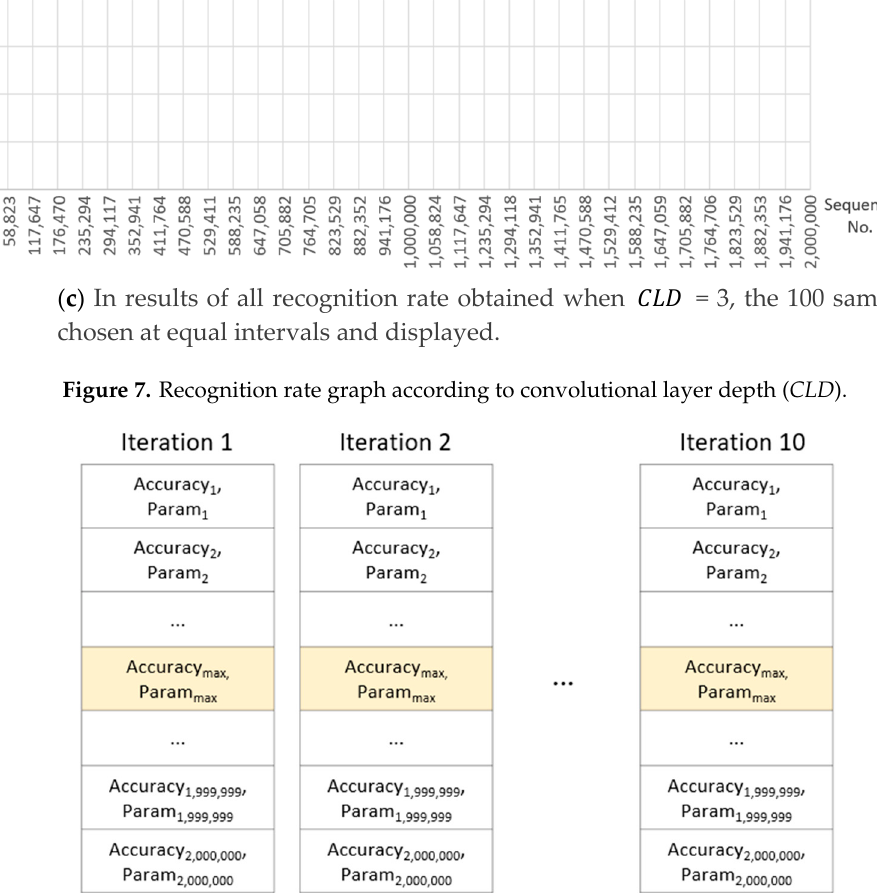
Figure 8. For iterative learning 10 times, find the combination of parameters (Param max ) with maximum recognition rate (Accuracy max ) per each iteration.